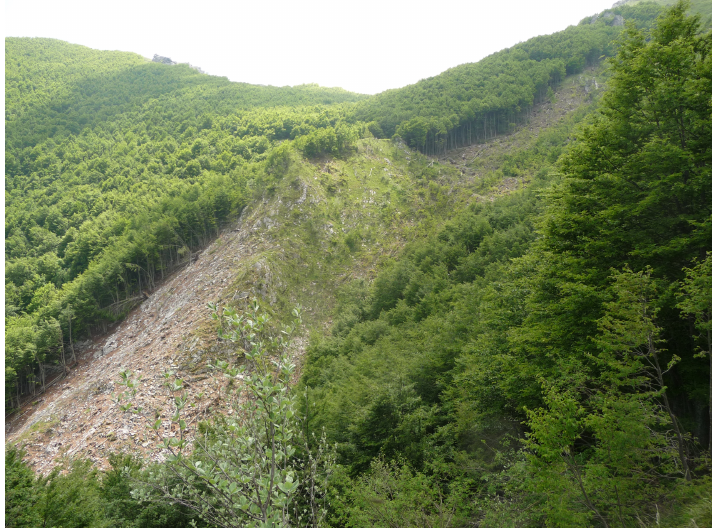
Figure 4. The shoulder at 1500m a.s.l., seen from the northern side of the gully. Note the strong curvature of the trajectory across the ridge and the complete destruction of the forest on the downward slope.